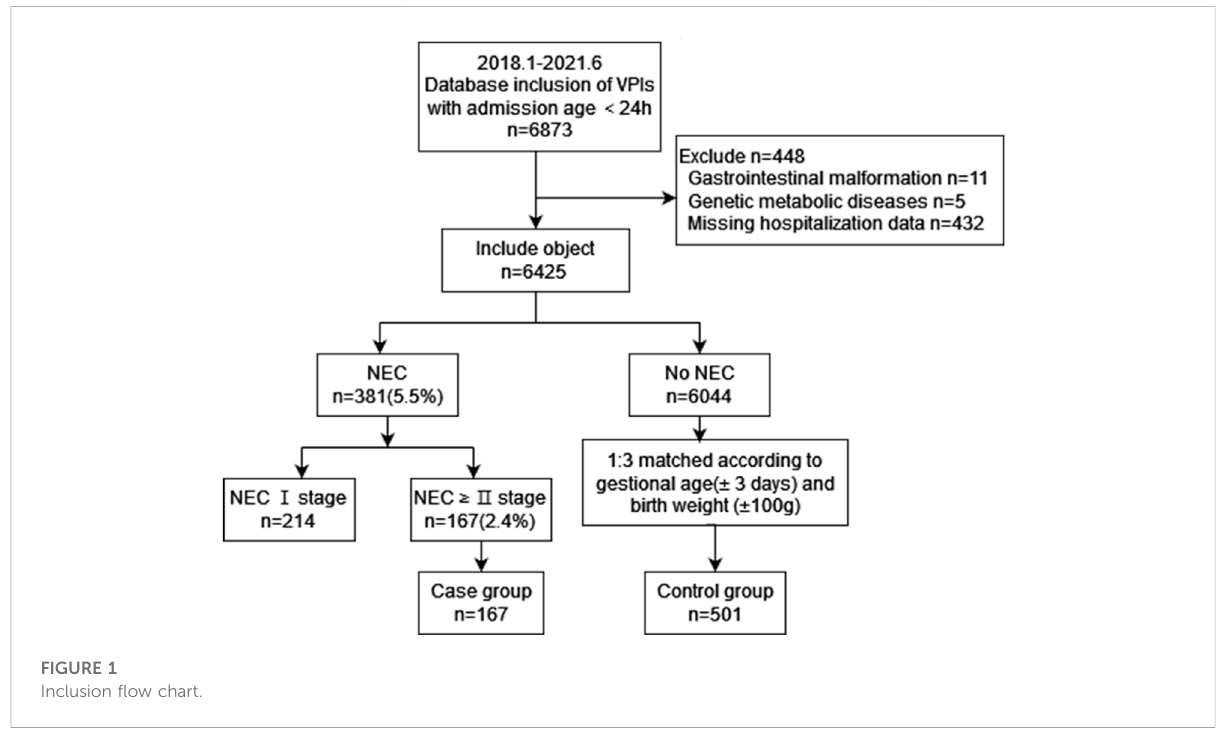
FIGURE 1 Inclusion fl ow chart.